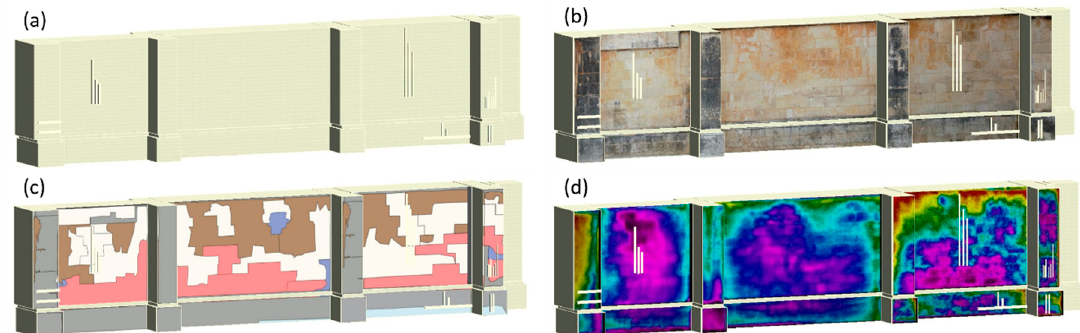
Figure 14. Three-dimensional model of the bottom part of the chapel façade with ( a ) location of the radargrams, ( b ) orthophoto image obtained with the unmanned aircraft system (UAS), ( c ) OBIA classification map and ( d ) thermographic image.